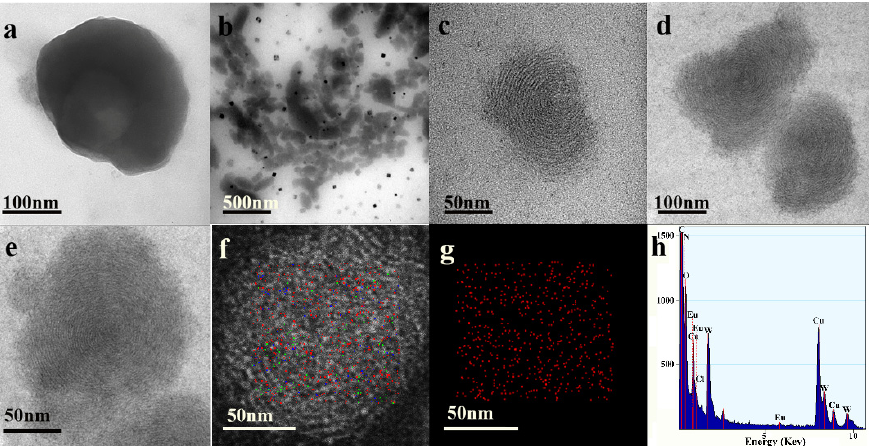
Figure 1. TEM and HRTEM images ( a – e ) of the OEu 3+ Phen complex under different magnifications in the different concentrations of oleic acid: 0.02 mol L − 1 ( a ), 0.05 mol L − 1 ( b , c ), 0.06 mol L − 1 ( d ), and 0.08 mol L − 1 ( e ), respectively. ( f , g ) EDS mapping images of the fingerprint-like nanostructures for 0.08 mol L − 1 oleic acid, and (f) shows all the elements of Eu (red), N (green), P (blue), while ( g ) shows only Eu 3+ element. ( h ) The EDS spectrum of the OEu 3+ Phen complexes for 0.05 mol L − 1 oleic acid.